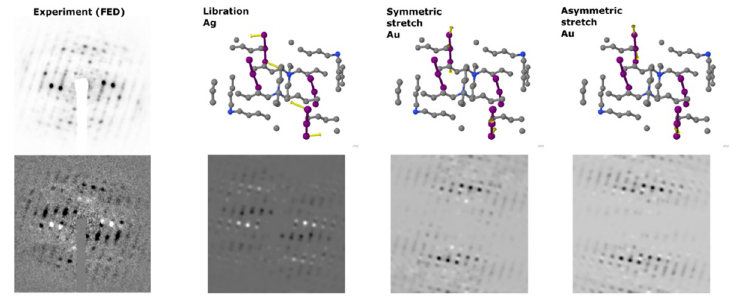
Fig. 1. An electron diffraction pattern of the ground state is shown in the upper left corner, and below it is the differential diffraction pattern recorded at 1 ps after photoexcitation (with light and dark shades being increasing and decreasing intensities, respectively). The next three paired plots to the right show selected ground-state phonon mode displacements and their corresponding effects on the diffraction pattern. The real space pictures on top are viewed from the direction of the electron beam. Each yellow arrow indicates the displacement vector of the corresponding atom. Here, the iodine atoms are depicted in purple, carbon in grey, nitrogen in blue, and hydrogens are omitted for clarity. The resulting changes in the diffraction pattern are presented in the lower three panels. The striking resemblance to the experimental differential diffraction pattern strongly suggests motion of iodine atoms along the libration and symmetric stretching coordinates upon